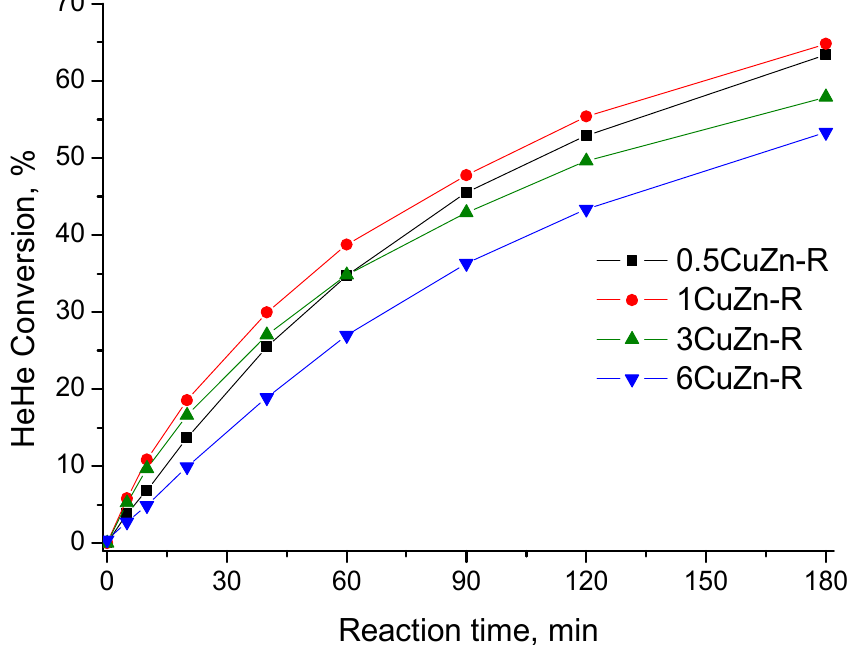
Figure 6. HeHe conversion in dependence on reaction time for different CuZn catalysts. HeHe load—138.2 g (0.69 mol), catalyst weight—1.5 g, T reac. = 210 °C, p H2 = 100 bar.